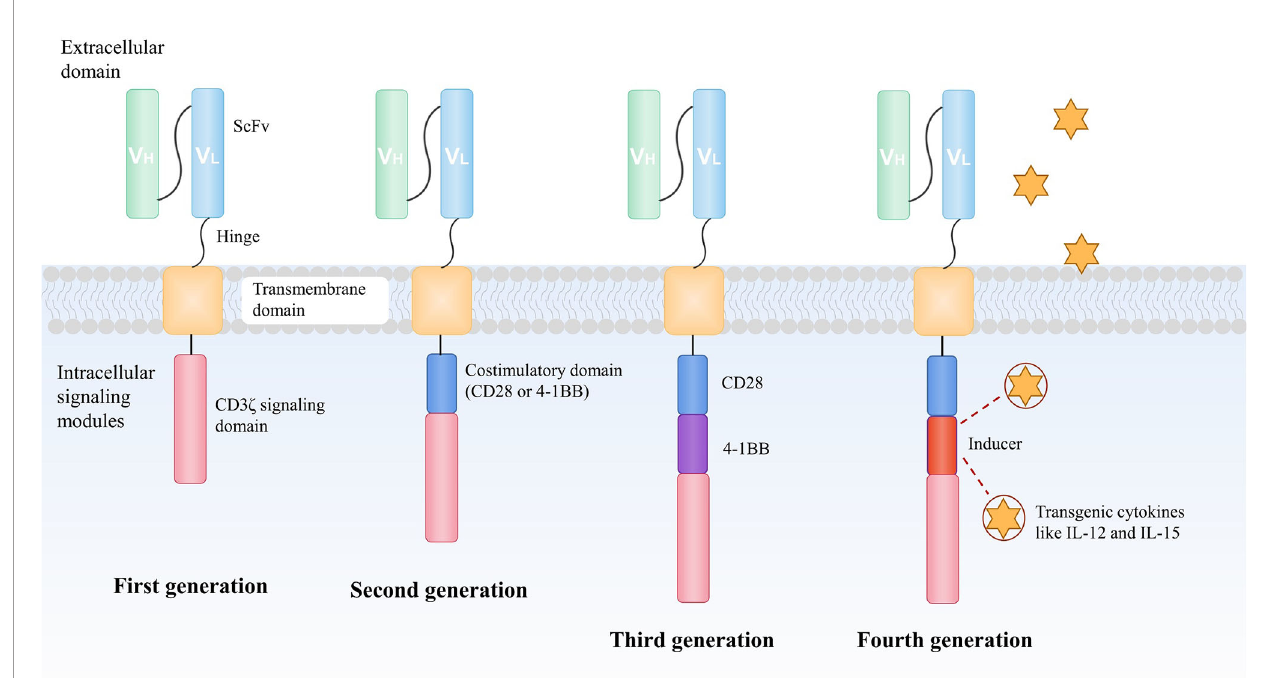
FIGURE 2 | The development of CAR construction. A CAR is composed of an extracellular antigen-binding domain, most of which is an antibody – derived scFV, a transmembrane domain and an intracellular signaling domain of the TCR CD3 z chain to activate T cells. To enhance the antitumor ability of CAR-T, the design of CARs has evolved over recent years. The second generation of CAR consists of an additional co-stimulatory domain, usually CD28 or 4-1BB (CD137) moieties to improve the capacity of persistence and proliferation of T cells. An extra co-stimulatory domain (CD28 and 4-1BB or TLR2) is added in the third-generation of CAR to further augment the ef fi cacy of infused CAR-T cells. In the fourth generation of CAR, the intracellular segment of the cytokine receptor is also added to the CAR, which effectively promotes the expansion of T cells. CAR, chimeric antigen receptor; scFv, antibody-derived single-chain variable fragment; TCR, T cell receptor; TLR, toll-like